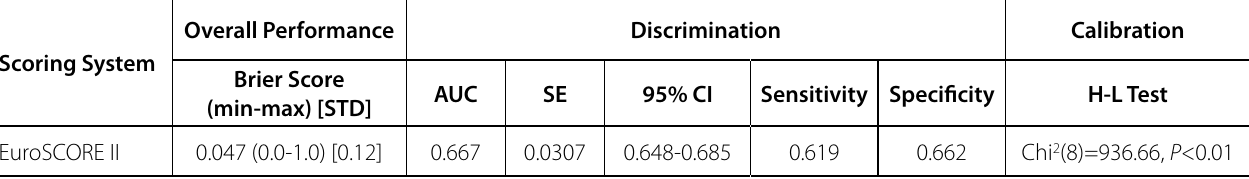
Table 4 . Performance measures calculated for EuroSCORE II scoring